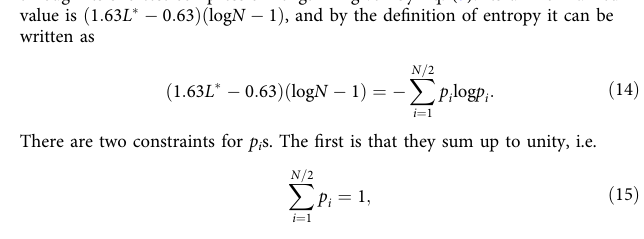
algorithm. Our fi nding is demonstrated upon data structure in prediction limit are linked through the underlying dynamical